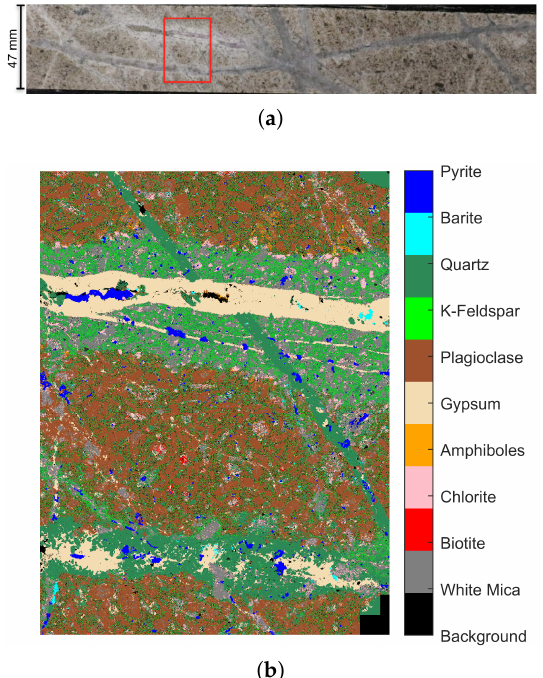
Figure 4. ( a ) RGB image of the drill core sample. The red rectangle represents the area where the ground truth fractional abundance maps were obtained by the scanning electron microscope (SEM)—mineral liberation analysis (MLA) analysis; ( b ) MLA